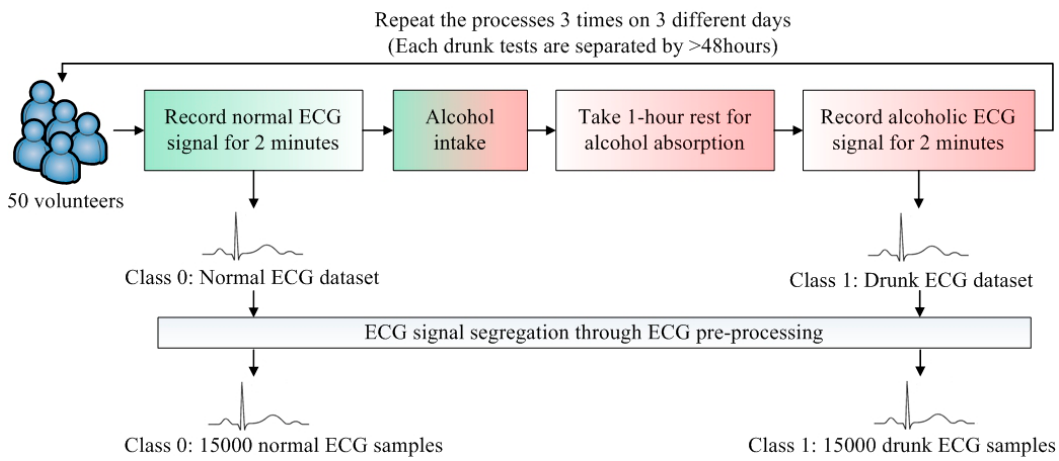
Figure 2. Flow of ECG data collection.